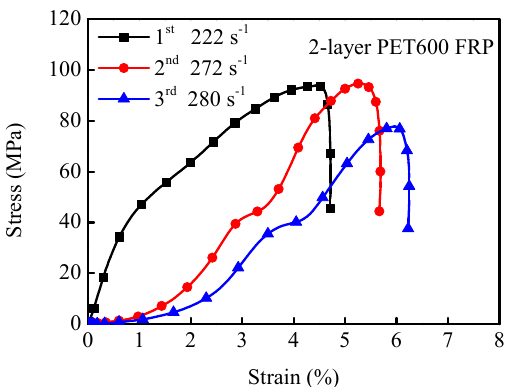
Figure 9. Dynamic compressive stress–strain curves of the specimen confined with two layers of the PET FRP under multiple impacts.